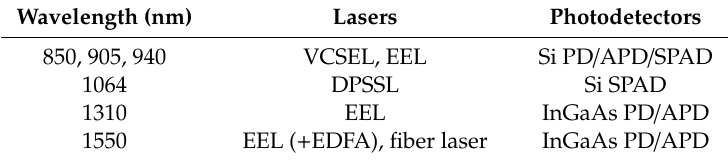
Table 4. Common laser sources and photodetectors for a LiDAR at di ff erent